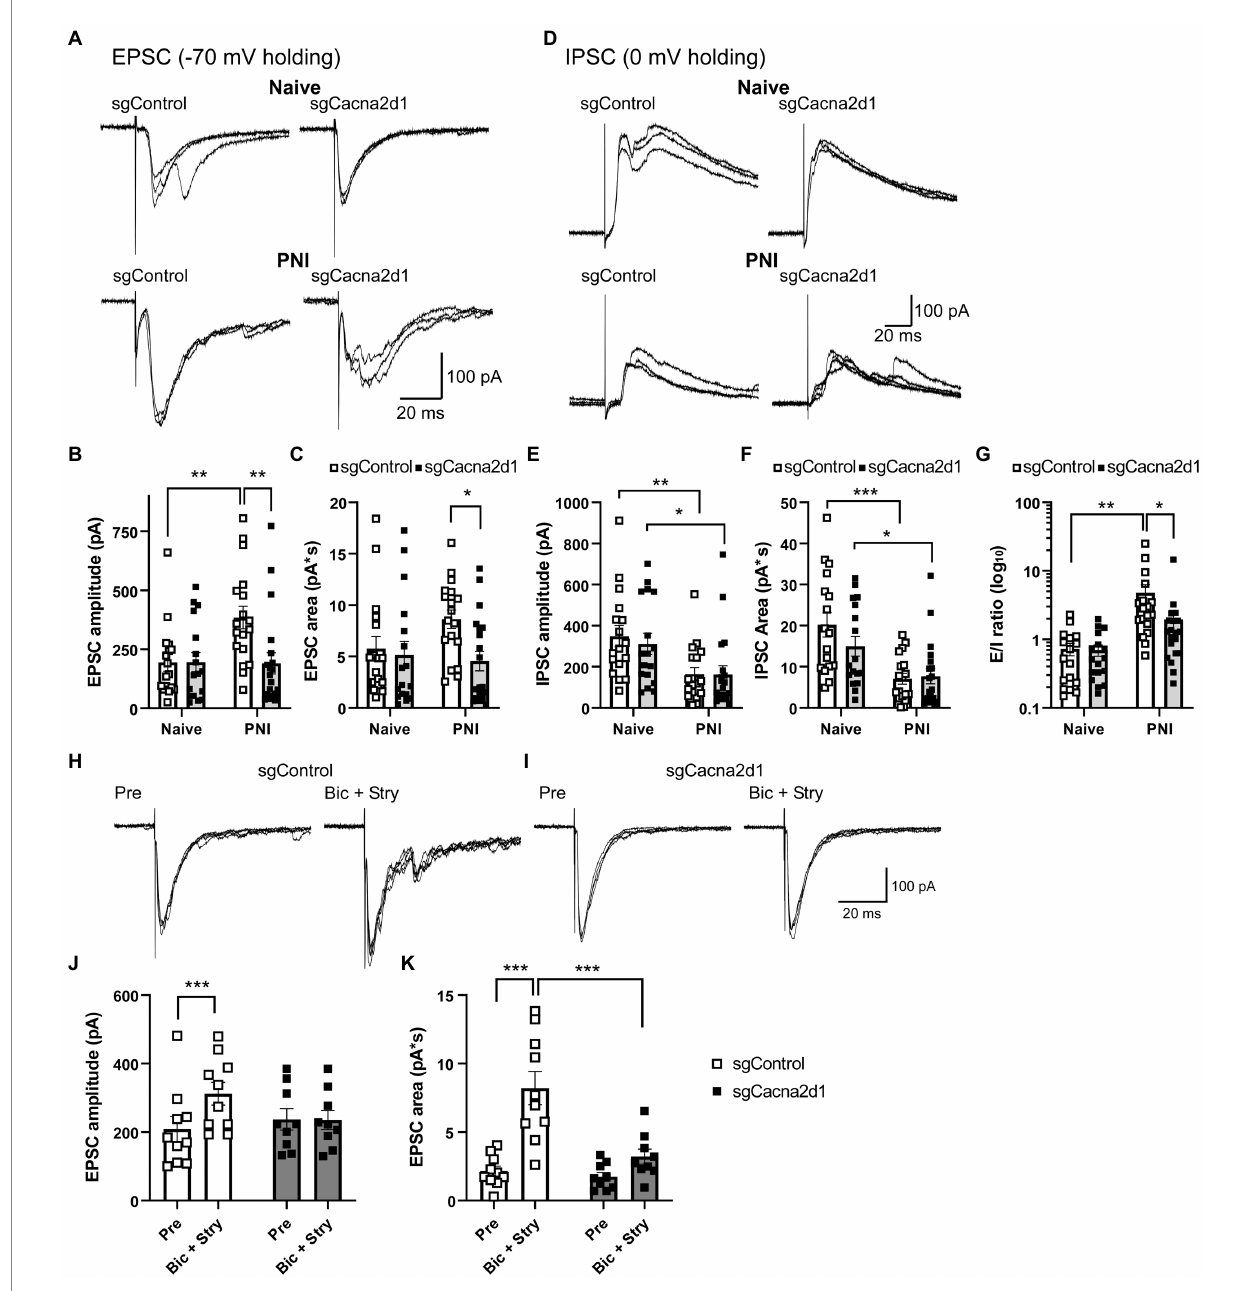
α 2 δ -1 in SDH neurons was involved in disinhibition-induced EPSC facilitation after PNI. (A) Representative traces showing eEPSCs in SDH neurons of sgControl ( left traces ) or sgCacna2d1 mice ( right traces ) without ( upper traces ) or with PNI ( lower traces ). (B,C) Summary showing eEPSC amplitude [ B : n = 17 (naïve, sgControl), n = 17 (naïve, sgCacna2d1), n = 18 (PNI, sgControl), n = 20 (PNI, sgCacna2d1), two-way ANOVA post hoc Bonferroni’s test, Group, F (1,68) = 4.93, p = 0.030, Treatment, F (1,68) = 4.52, p = 0.037, Interaction F (1,68) = 5.04, p = 0.028, **p < 0.01] and eEPSC area [ C : n = 17 (naïve, sgControl), n = 17 (naïve, sgCacna2d1), n = 18 (PNI, sgControl), n = 20 (PNI, sgCacna2d1), two-way ANOVA post hoc Bonferroni’s test, Group, F (1,68) = 4.61, p = 0.035, Treatment, F (1,68) = 1.06, p = 0.306, Interaction F (1,68) = 2.54, p = 0.116, * p < 0.05]. (D) Representative traces showing eIPSCs in SDH neurons of sgControl ( left ) or sgCacna2d1 mice ( right ) without ( upper ) or with PNI ( lower ). (E,F) Summary showing eIPSC amplitude [ E : n = 17 (naïve, sgControl), n = 17 (naïve, sgCacna2d1), n = 18 (PNI, sgControl), n = 20 (PNI, sgCacna2d1), two-way ANOVA post hoc Bonferroni’s test, Group, F (1,68) = 0.181, p = 0.672, Treatment, F (1,68) = 14.0, p = 0.0004, Interaction F (1,68) = 0.168, p = 0.684, * p < 0.05 , ** p < 0.01], and eIPSC area [ F : n = 17 (naïve, sgControl), n = 17 (naïve, sgCacna2d1), n = 18 (PNI, sgControl), n = 20 (PNI, sgCacna2d1), two-way ANOVA post hoc Bonferroni’s test, Group, F (1,68) = 1.14, p = 0.289, Treatment, F (1,68) = 22.0, p < 0.0001, Interaction F (1, 68) = 1.79, p = 0.185, * p < 0.05 , ***p < 0.001]. (G) Summary of E/I ratio of each group. [ n = 17 (naïve, sgControl), n = 17 (naïve, sgCacna2d1), n = 18 (PNI, sgControl), n = 20 (PNI, sgCacna2d1), two-way ANOVA post hoc Bonferroni’s test, Group, F (1,68) = 2.99, p = 0.089, Treatment, F (1,68) = 10.3, p = 0.002, Interaction F (1,68) = 2.87, p = 0.095, * p < 0.05 , **p < 0.01]. (H,I) Representative traces showing eEPSCs in SDH neurons of sgControl (H) or sgCacna2d1 (I) mice before ( left ) and after bicuculine (10 μ M) and strychnine (1 μ M) application (Bic + Stry, right ). (J,K) Summary showing eEPSC amplitude of each group [ J : n = 10 (sgControl), n = 9 (sgCacna2d1), two-way repeated measurements ANOVA post hoc Bonferroni’s test, Group, F (1,17) = 0.319, p = 0.580, Treatment, F (1,17) = 9.59, p = 0.007, Interaction F (1,17) = 10.3, p = 0.005, ***p < 0.001] and eEPSC area of each group [ K : n = 10 (sgControl), n = 9 (sgCacna2d1), two-way repeated measurements ANOVA post hoc Bonferroni’s test, Group, F (1,17) = 11.5, p = 0.003, Treatment, F (1,17) = 32.4, p < 0.0001, Interaction F (1,17) = 11.2, p = 0.003, ***p < 0.001]. Data are mean ±